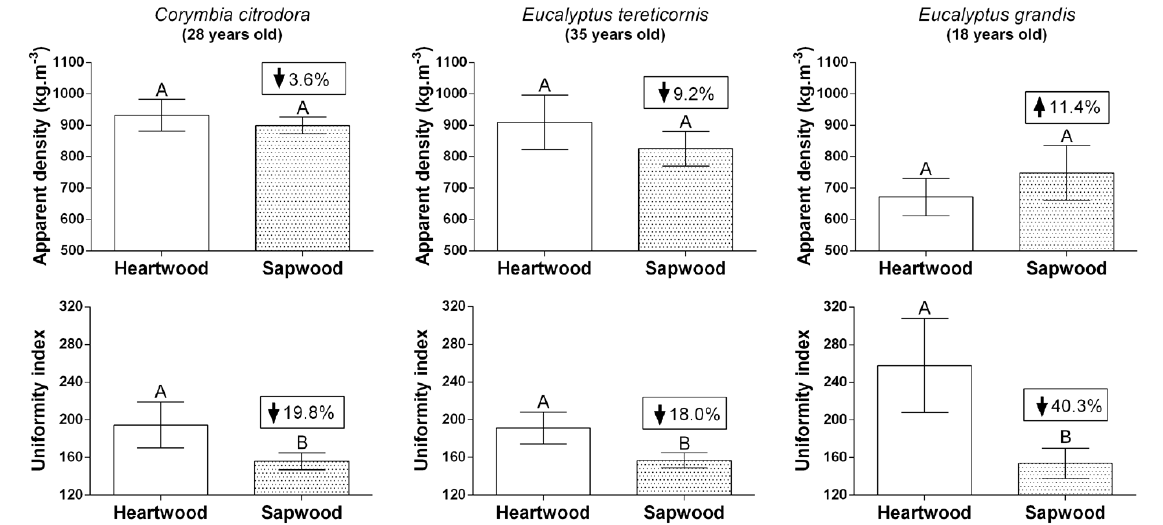
Figure 5 - Histograms of variation in weighted apparent density and uniformity index (with standard deviation) in the heartwood and sapwood of the three species